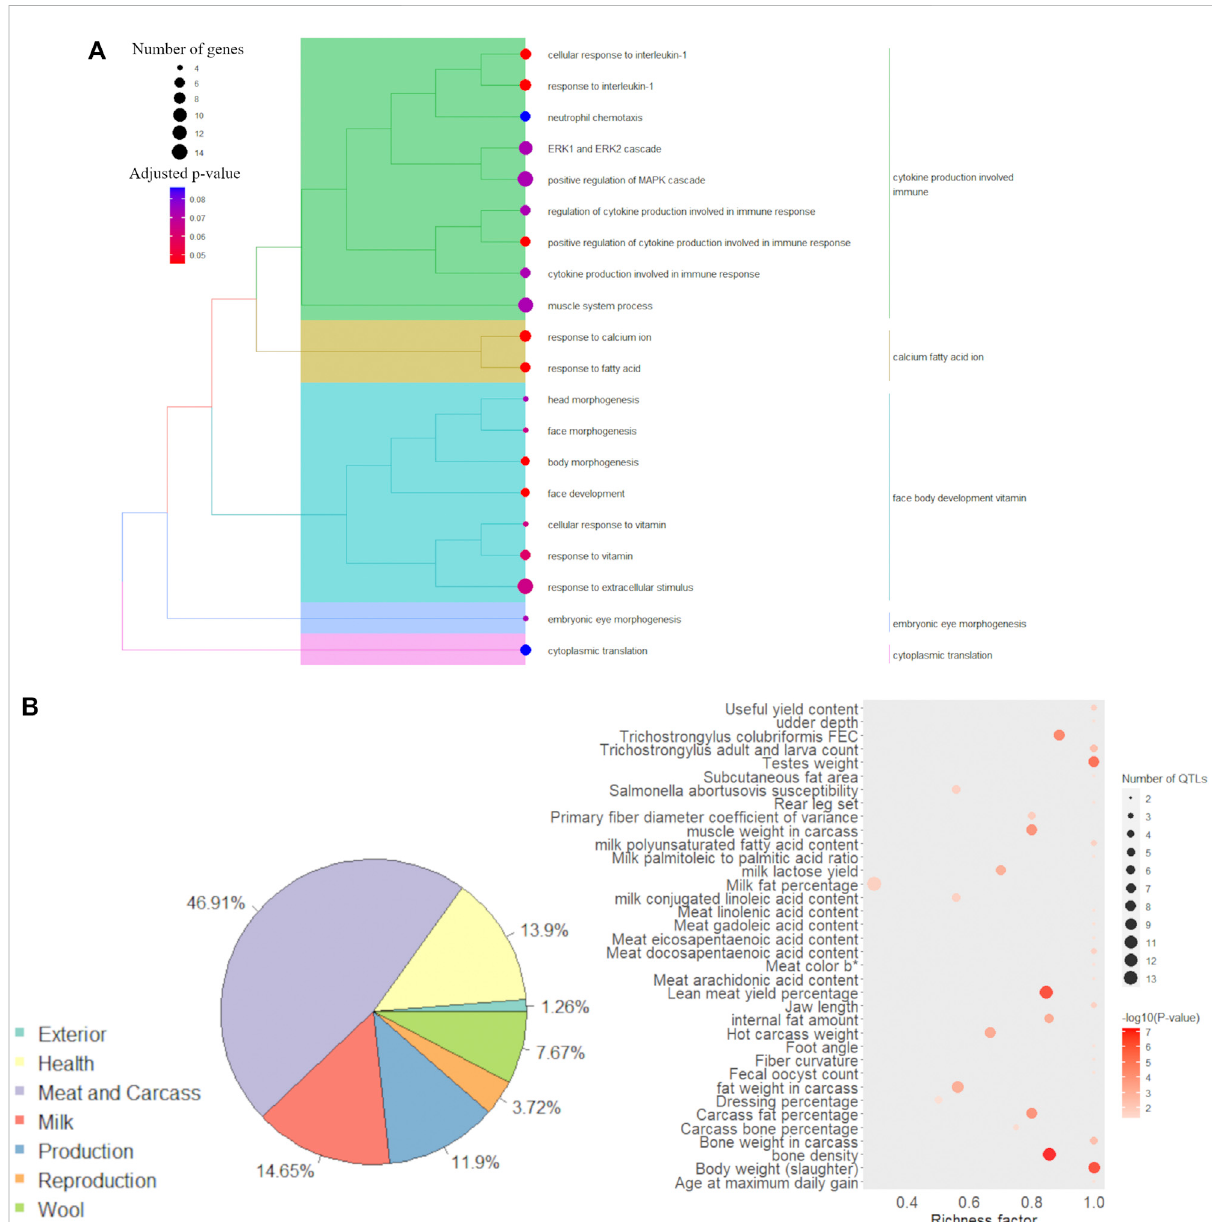
FIGURE 5 Functional analysis for the 314 discriminant genes obtained in the (s)PLS-DA discriminant analysis between male and female samples. (A) Functional grouping tree diagram for the Gene Ontology (GO) terms annotated for the 314 genes selected after the multiblock (s)PLS-DA discriminant analysis. Each color in the dendrogram represents a functional group obtained after estimating the Jaccard correlation coef fi cient. The area of the circles represents the number of genes assigned to each GO term, and the color of the circle indicates the p -value estimated for each GO term. (B) Pie plot showing the percentage of each QTL type annotated within the genomic coordinate of the 314 discriminant genes and bubbleplotwithQTLenrichmentanalysis results, where thedarkertheshadeofred,thesmallest istheenrichment p -valueand theareaofthecircle represents the number of annotated